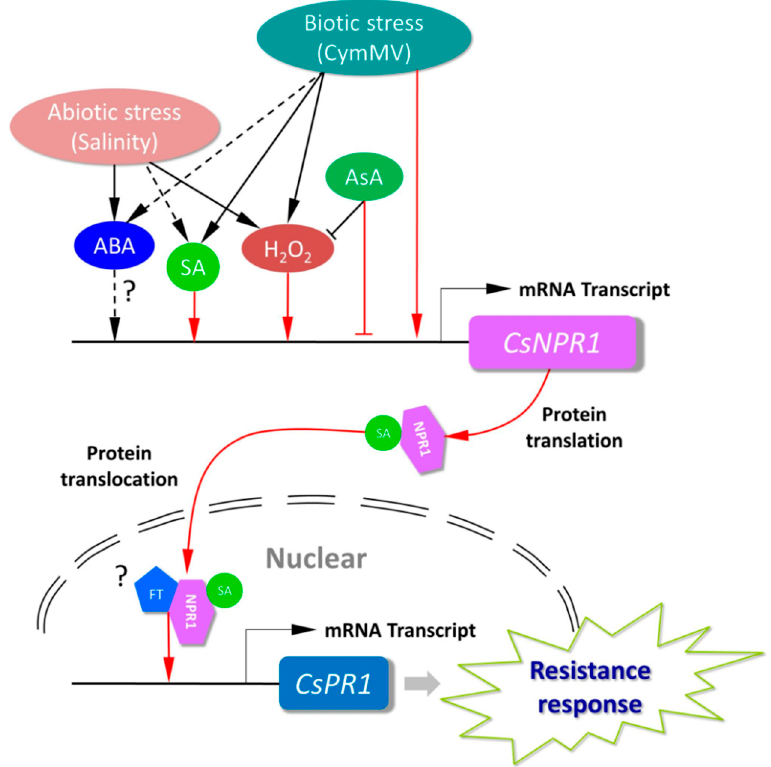
Figure 9. NPR1-mediated signaling pathway in Cymbidium orchid. Stress and phytohormones are represented by ellipses; genes are represented by rectangles; and lines before rectangles represent the transcriptional regulatory regions. Lines with an arrow represent the promotion of mRNA transcript, and those with a perpendicular bar represent repression. Red lines indicate the regulation or transportation demonstrated in this study.